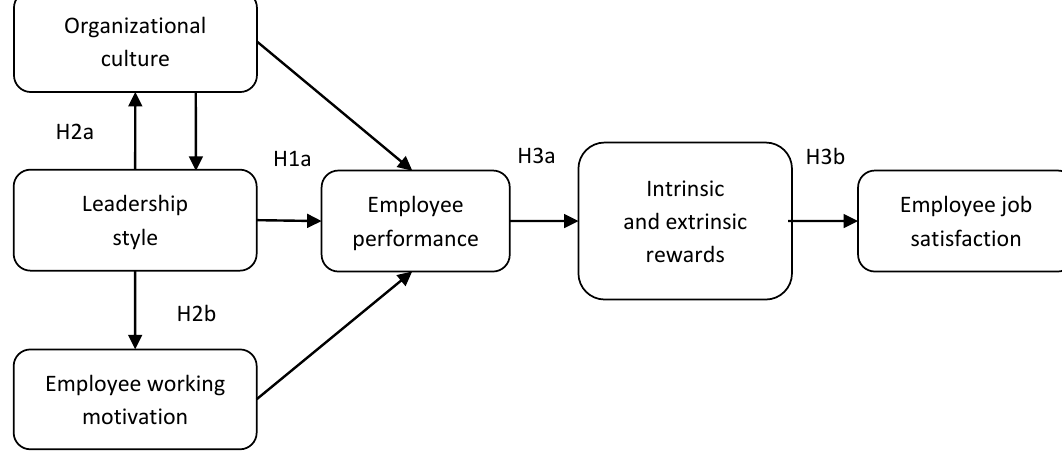
Figure 1. Conceptual